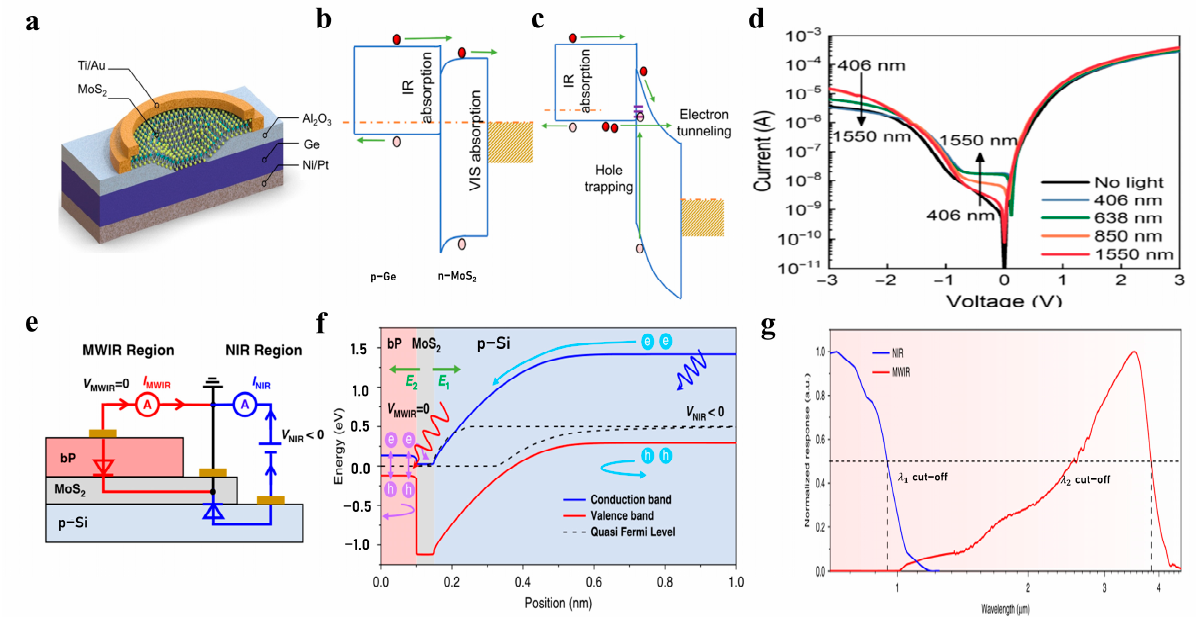
Figure 7. Two-color infrared detector. ( a ) Schematic diagram of p-Ge/n-MoS 2 two-color infrared detector for VIS and infrared selective detection [112] (copyright 2021, American Association for the Advancement of Science). ( b , c ) Energy band diagrams under infrared light and visible light,